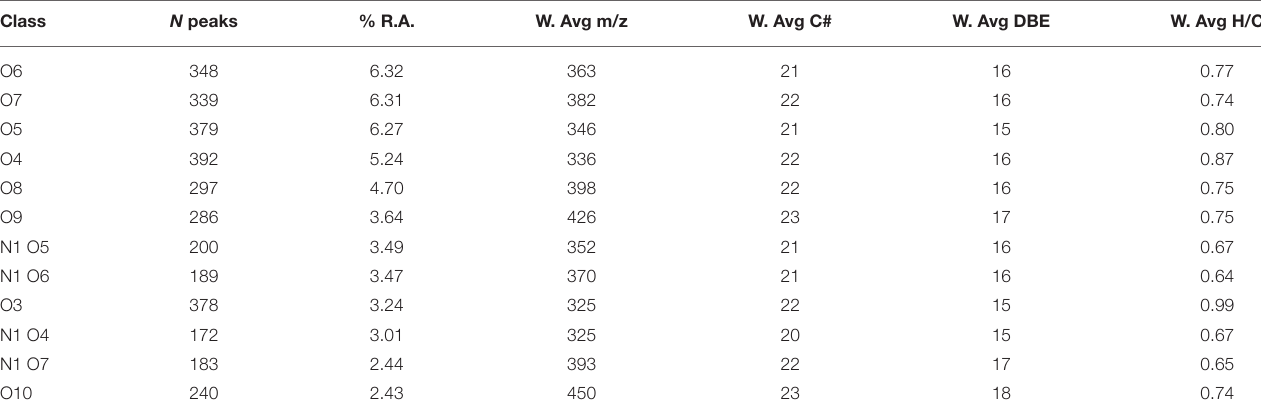
TABLE 2 | Parameters for the main class distribution contributing up to 50% of the relative abundance. Class N peaks %